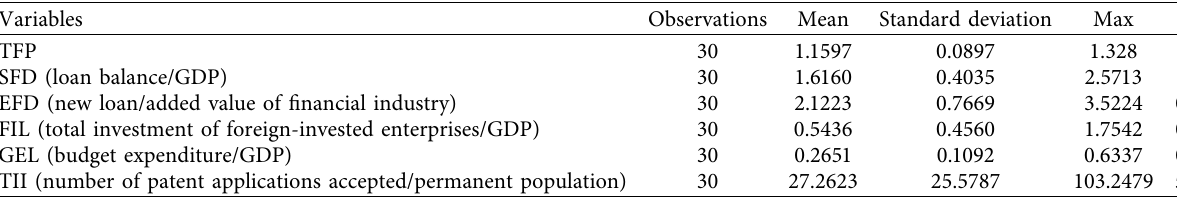
Figure 2: Comparison of TFP index and technology progress index in different Table 2: Summary statistics of all the variables.